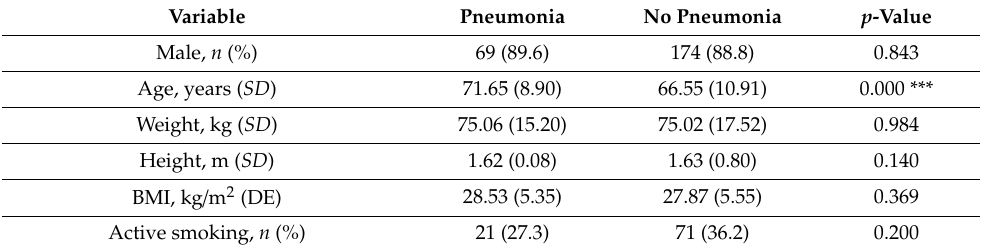
Table 2. Anthropometric, lung function, phenotype, and treatment data according to the presence or absence of